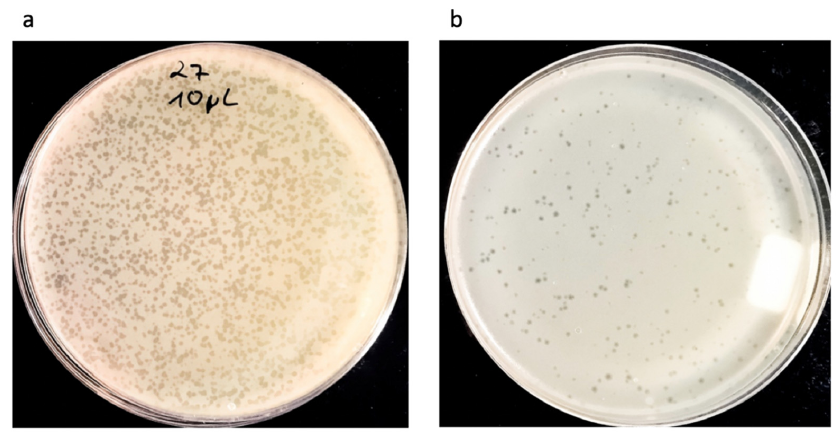
Figure 1. Lysate of propagated prophage of ( a ) PSTy27 a S . enterica serovar Typhimurium isolate on host strain ATCC 14028 WT and ( b ) PSEn7 a S . enterica serovar Enteritidis on host strain DSM 17420 (pictures were taken by the authors).